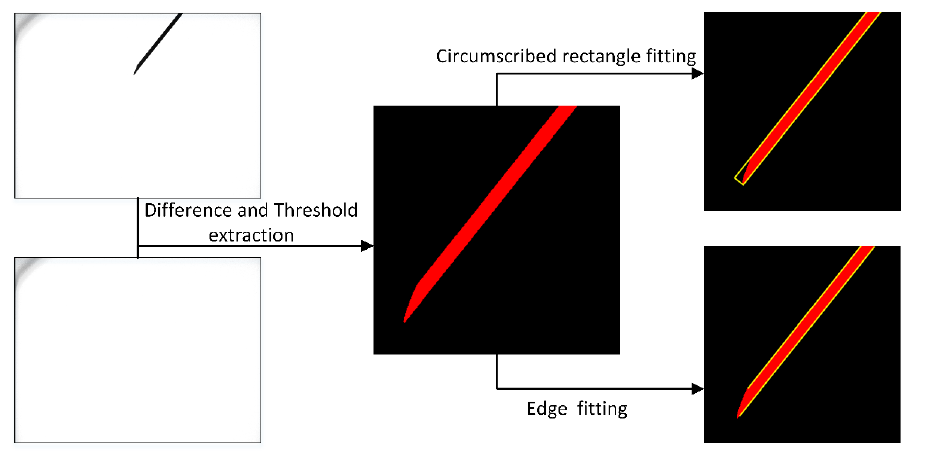
Figure 6. Sample of image processing.